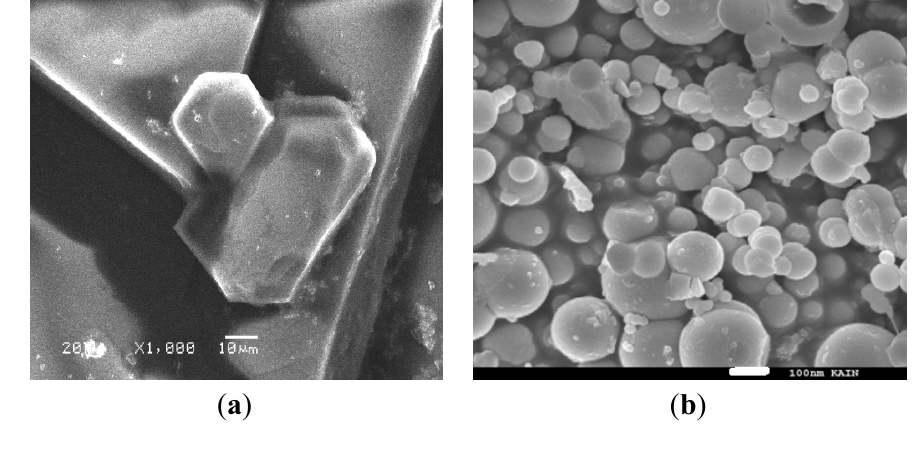
Figure 8. SEM micrographs ( a ) NiCl and ( b ) NiO